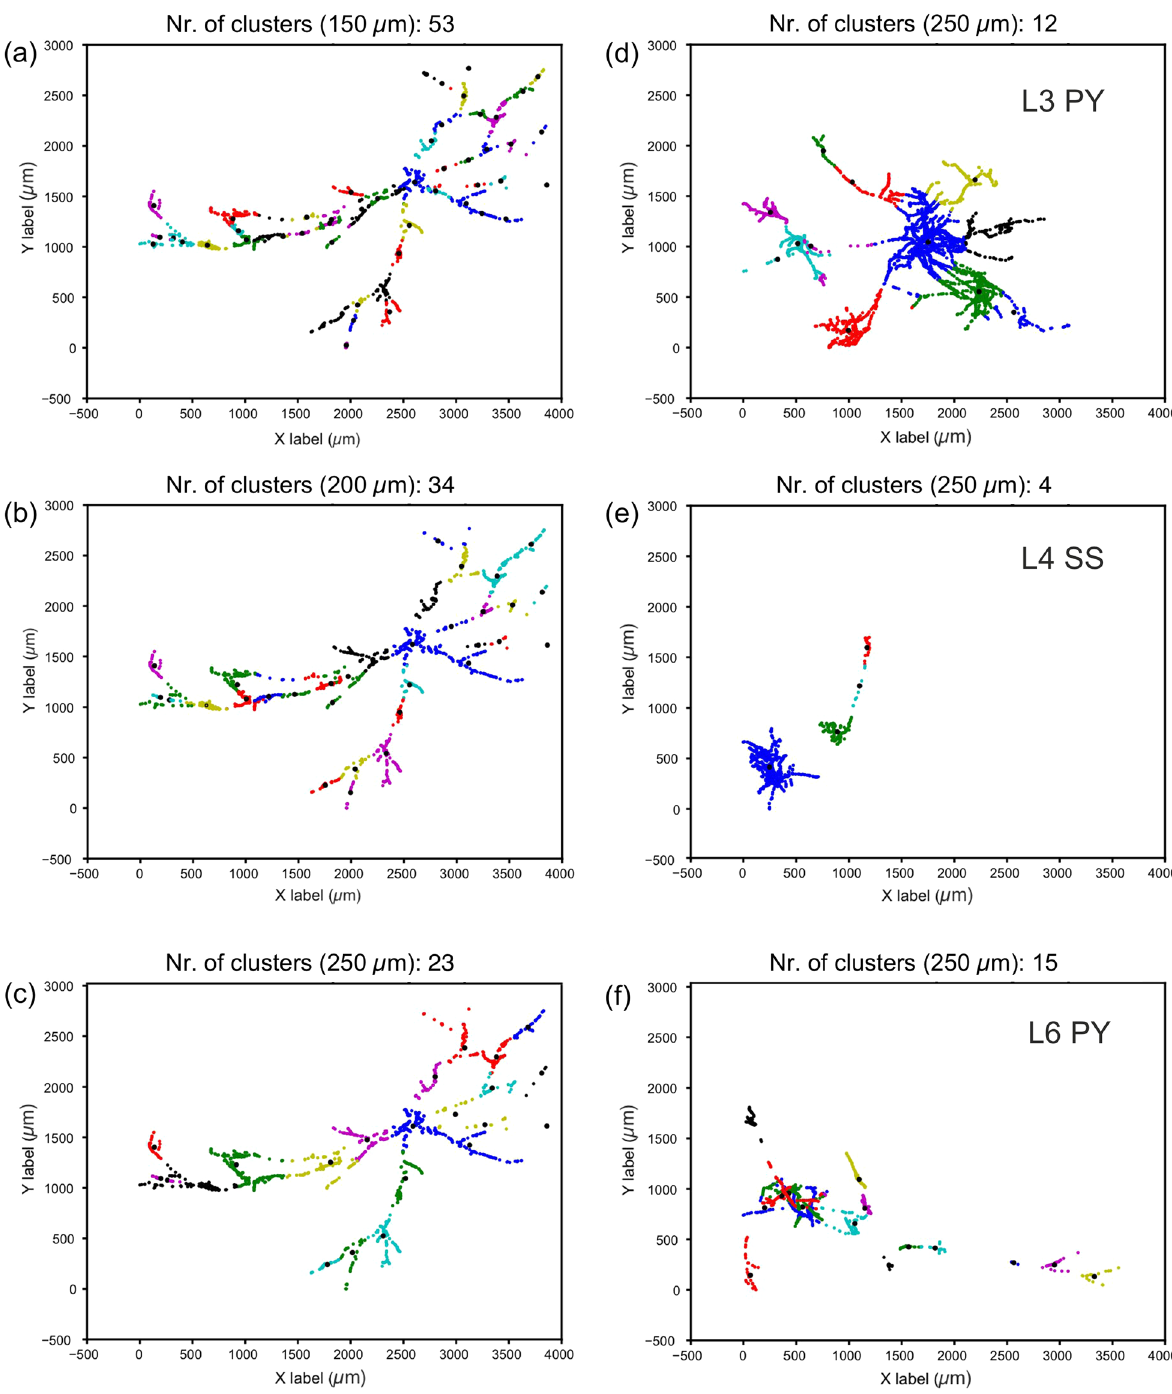
Figure 3. Cluster analysis of the L6SC boutons ( a – c ) and comparison with that of known spiny (excitatory) neurons type ( d – f ). For L6SC, the mean-shift algorithm produced different number of clusters as a function of kernel size (in parenthesis). Smaller kernel size produced larger number of clusters ( a ) as opposed larger kernel size which produced smaller number of clusters ( b , c ). Bouton clustering depends on lateral extent and spatial organization. Using the same kernel size (250 µm) applied in panel ( c ) for L6SC, the exemplary L3 pyramidal cell axon ( d ), L4 spiny stellate axon ( e ), and L6 pyramidal cell axon ( f ) returned 12, 4, and 15 bouton clusters, respectively. For clarity, clusters are shown in color and their centers indicated with small black circles (data were plotted using SpyderIDE 5.1.5, https:// www. spyder- ide. org, for further details, see